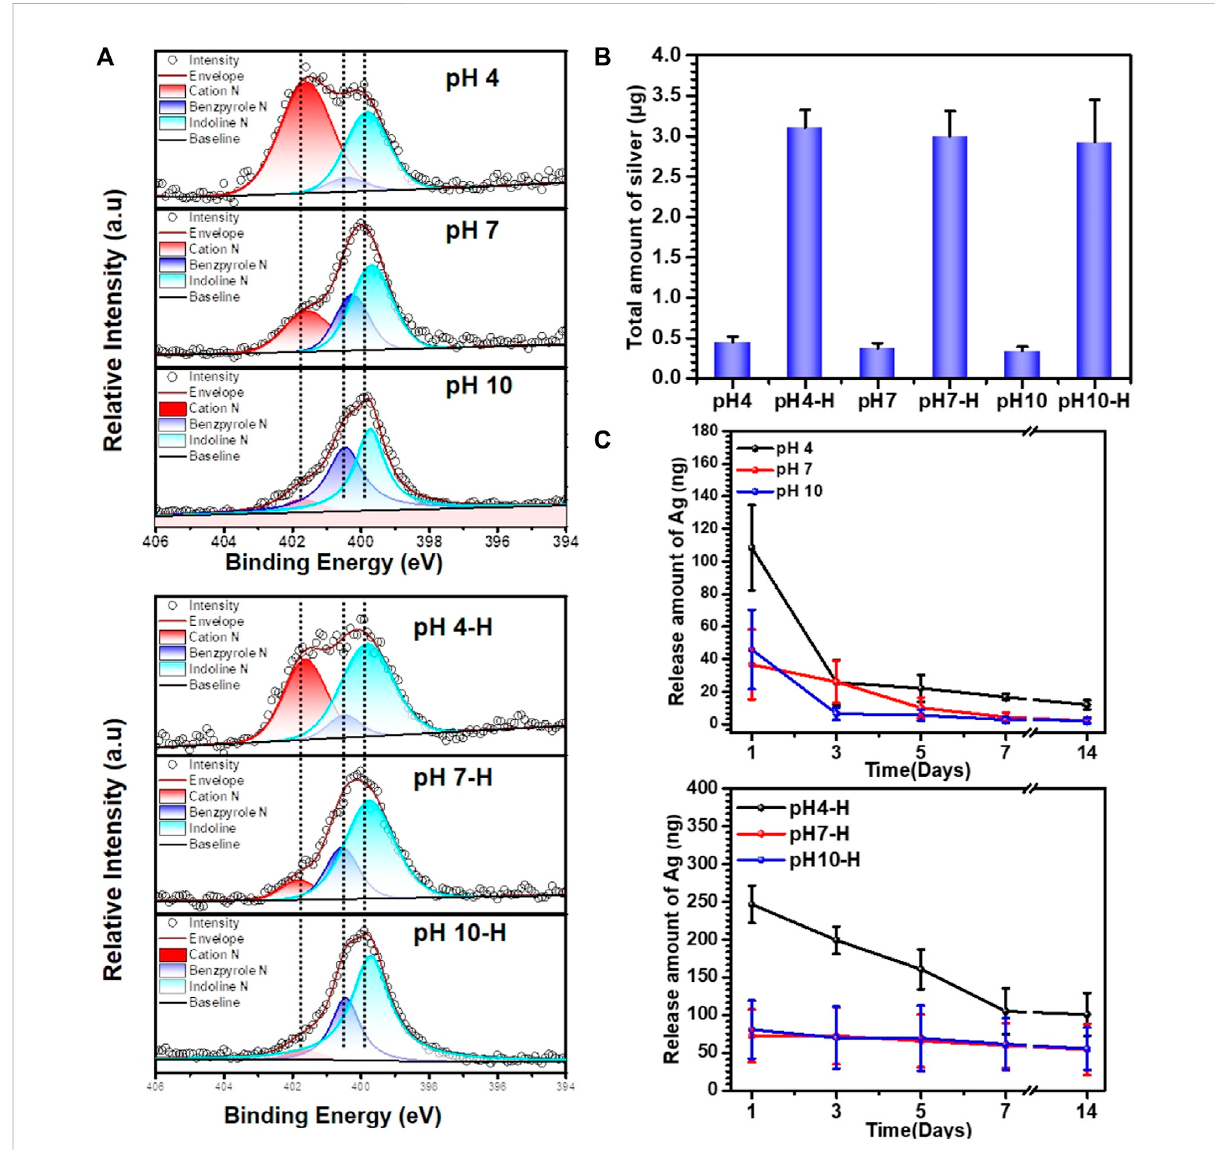
FIGURE 2 Characterization of different samples: (A) XPS high-resolution N analyses of pH4-H, pH7-H and pH10-H; (B) total amount of Ag in different samplesinvestigatedbyInductively CoupledPlasmaMassSpectrometry(ICP-MS); (C) thereleaseamountwithtimeofdifferentsamplesdetectedby